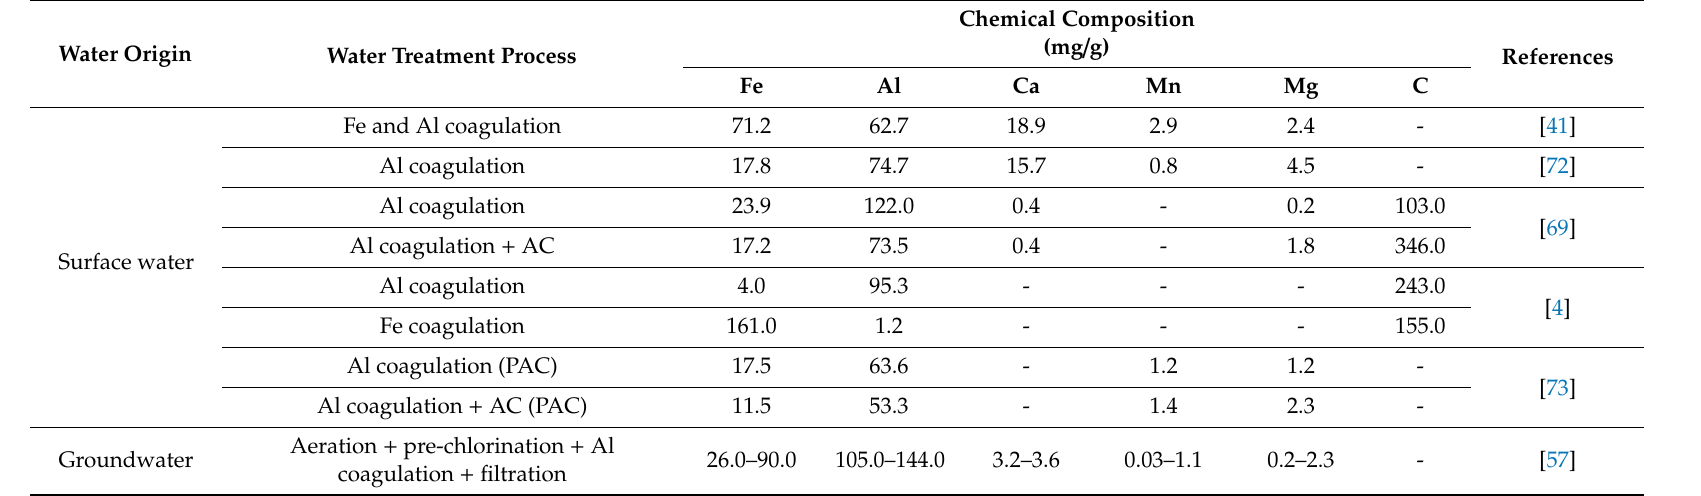
Table 2. The concentration of selected elements in the post-coagulation water treatment residuals. (PAC—polyaluminum chloride, AC—activated carbon).